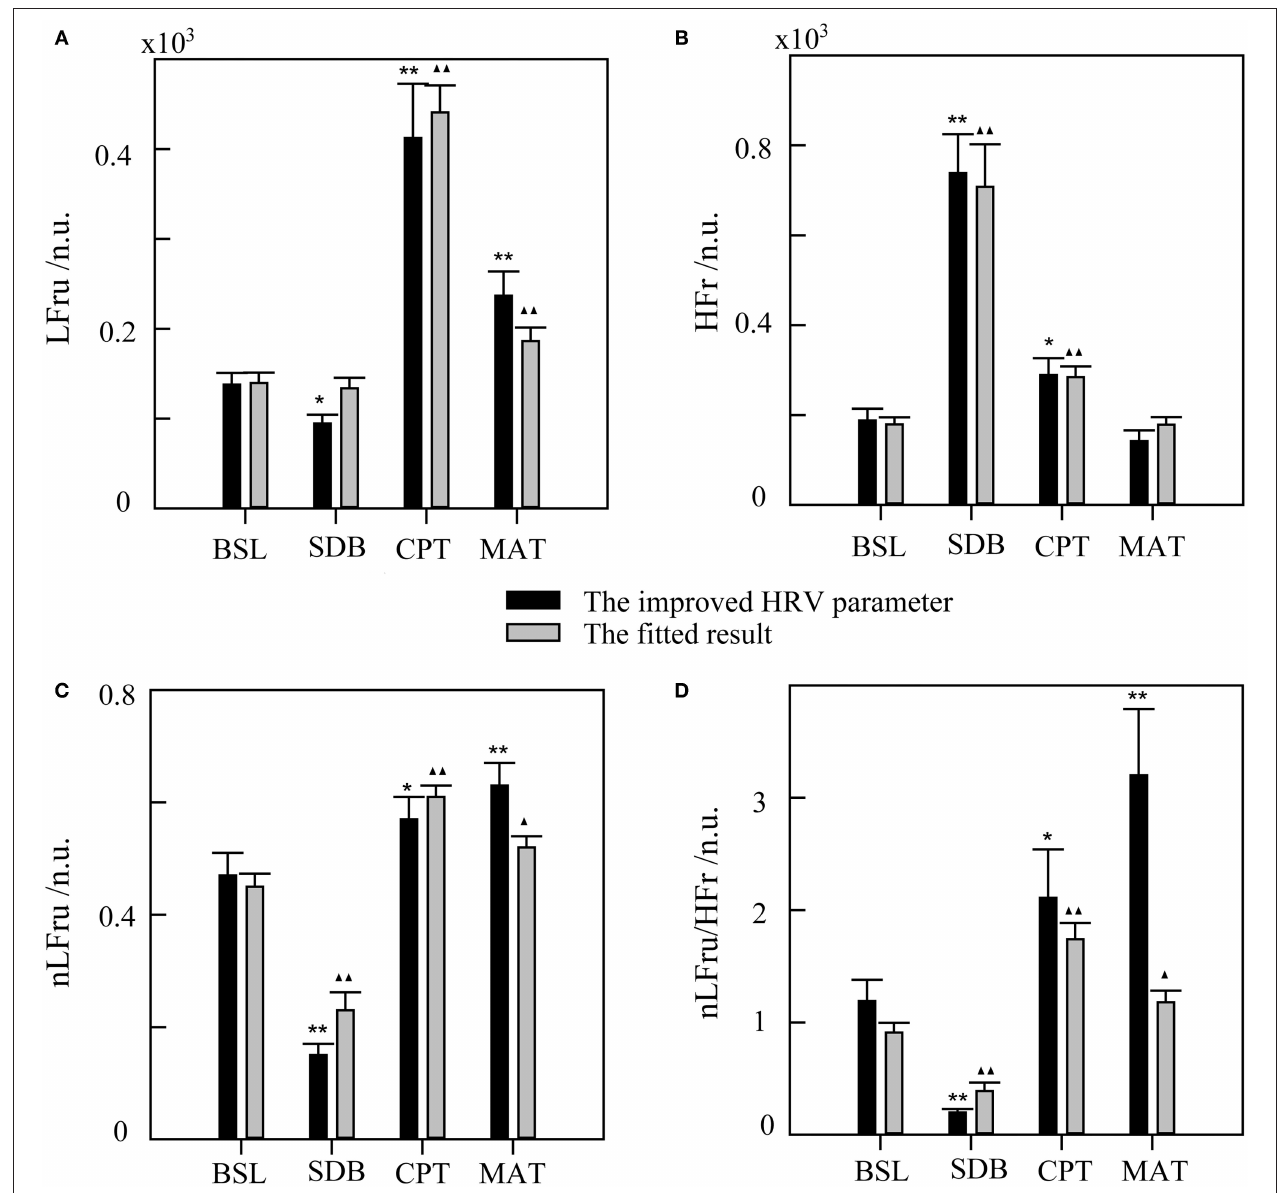
FIGURE 6 | The statistical results of slow deep breathing (SDB), the cold pressor test (CPT), and the mental arithmetic test (MAT) compared with the baseline state (BSL) for the improved HRV parameters and fitting data. (A) LFru, low-frequency power of the improved HRV. (B) HFr, high-frequency power of the improved HRV. (C) nLFru, normalized low-frequency power. (D) LFru/HFr, the ratio of LFru to HFr. The significance of the differences in the improved HRV parameters between each experimental state and BSL state is denoted by * for p < 0.05 and ** for p <0.01. N and NN indicate p < 0.05 and p < 0.01, respectively, for the corresponding comparisons of the fitted result. The physiological mechanism of the improved HRV parameters are considered as follows: LFru mainly contains information on sympathetic activity, HFr reflects parasympathetic activity, nLFru is a relatively pure measure of sympathetic activity, and LFru/HFr reflects sympathovagal balance. [Std(T), Std(T3), LF, TP, nLF, LF/HF, and SampEn]